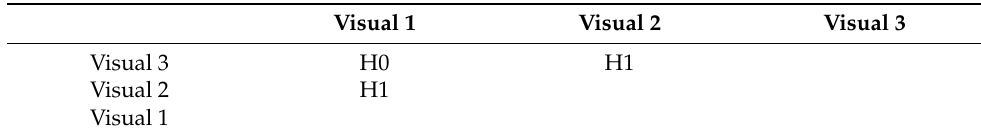
Figure 8. Valence during the evaluation of waffles served in three different ways. Table 2. Wilcoxon paired test—comparison of valence of individual visuals.